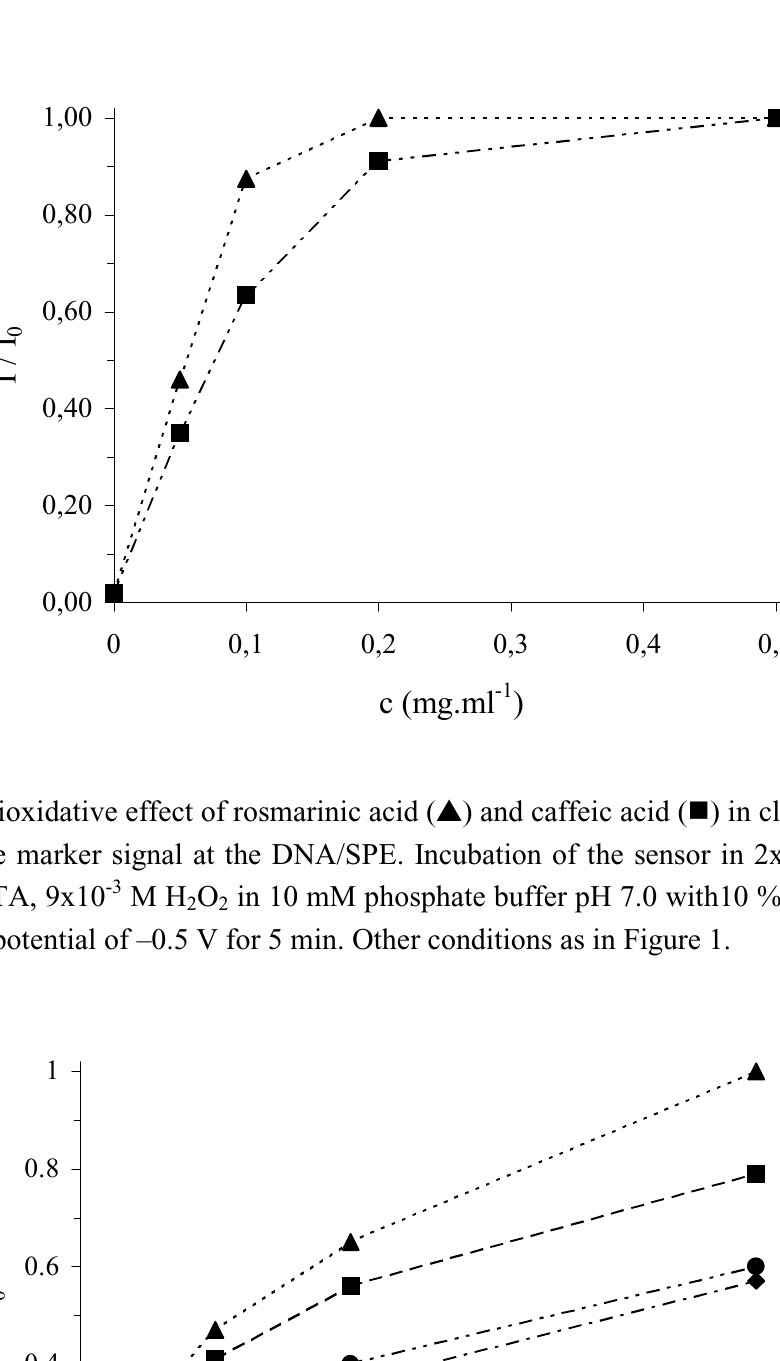
Figure 4. Antioxidative effect of plant extracts in cleavage mixture on the relative marker signal at the DNA/SPE: lemon balm ( (cid:86) ), oregano ( (cid:132) ), thyme ( (cid:79) ) and agrimony ( (cid:88) ). Other conditions as in Figure